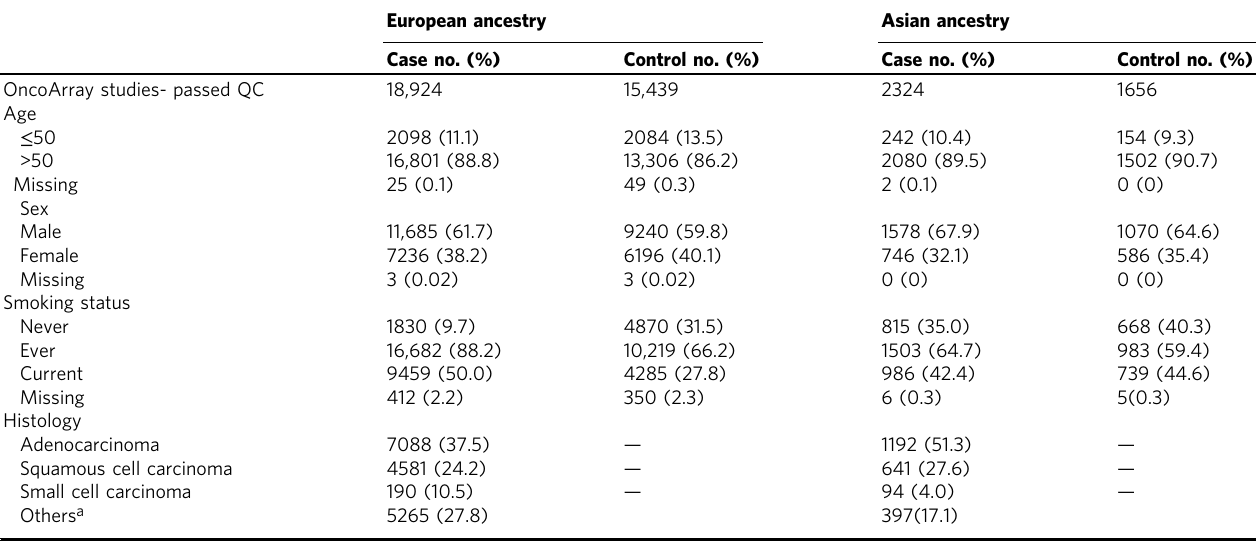
Table 1 Demographic characteristics of the participating studies after quality control fi lters European